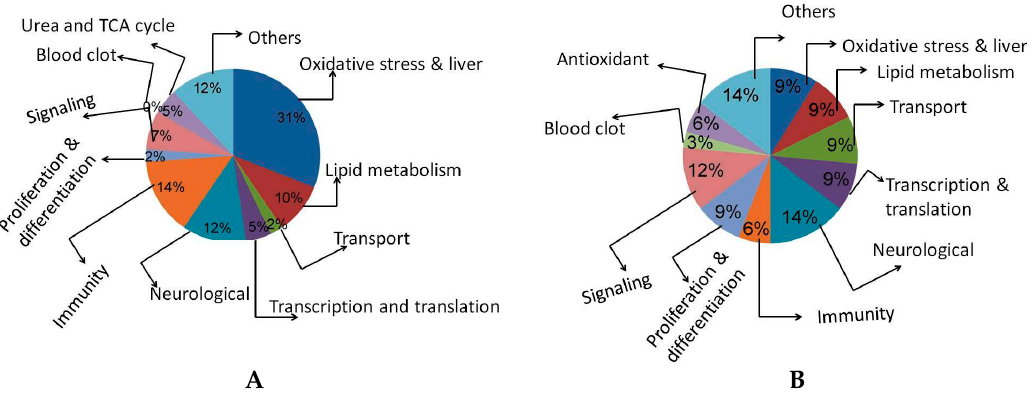
Figure 6. Classification of proteins based on their putative function extracted from experimental rat livers. A —150 mg/kg of APAP-treated rats; B —1500 mg/kg of APAP-treated rats.